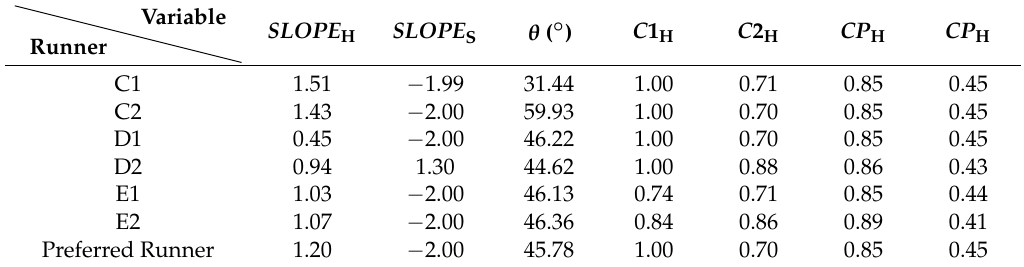
Table 9. Performances of the selected runners.